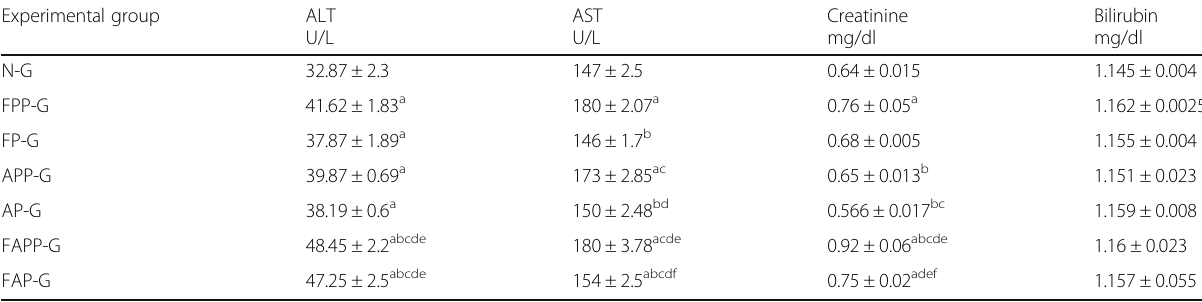
Table 2 Activities of alanine aminotransferase (ALT) and aspartate aminotransferase (AST), the levels of creatinine and bilirubin in serum of offspring rats exposed to NaF or AlCl 3 alone and in combination through the pre- or/and postnatal stages until 70 days Experimental